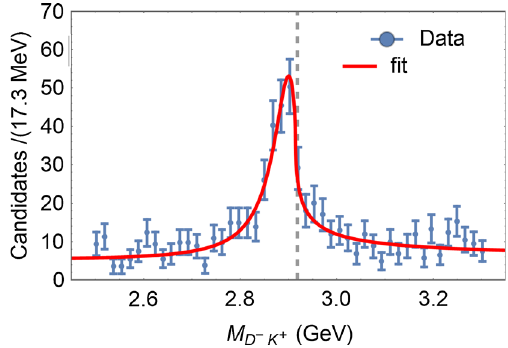
Fig. 2 Fit result with explicit X 1 ( 2900 ) . The dashed vertical line is located at the threshold of ¯ D 1 K . Data are from Ref.